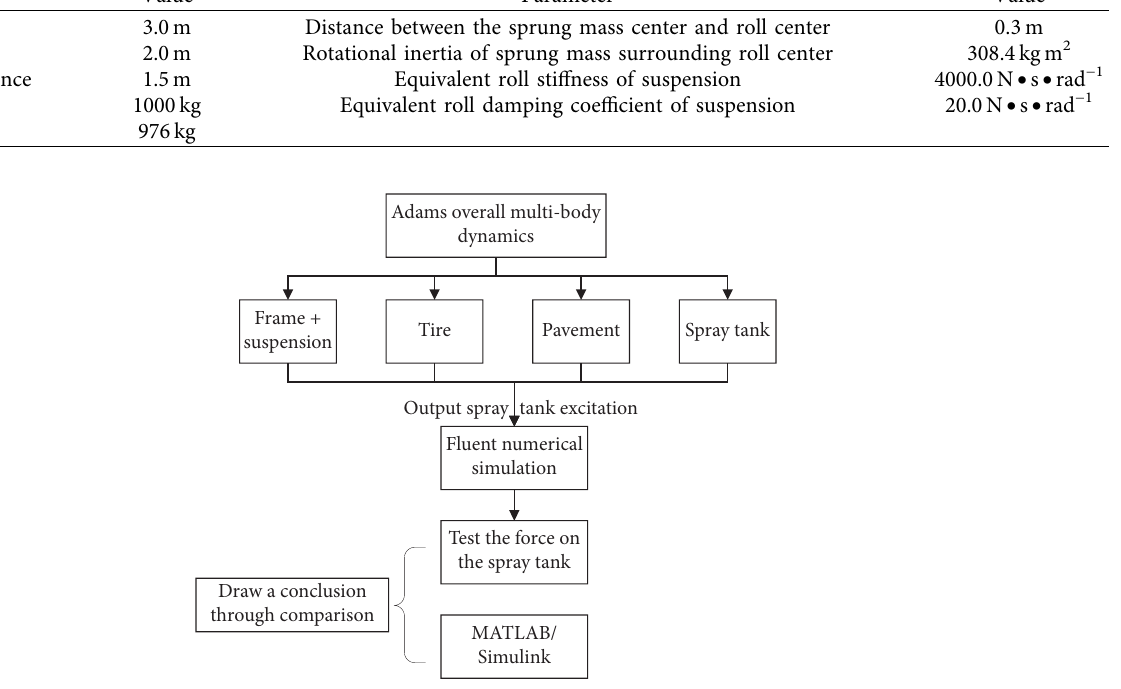
Figure 2: Simulation